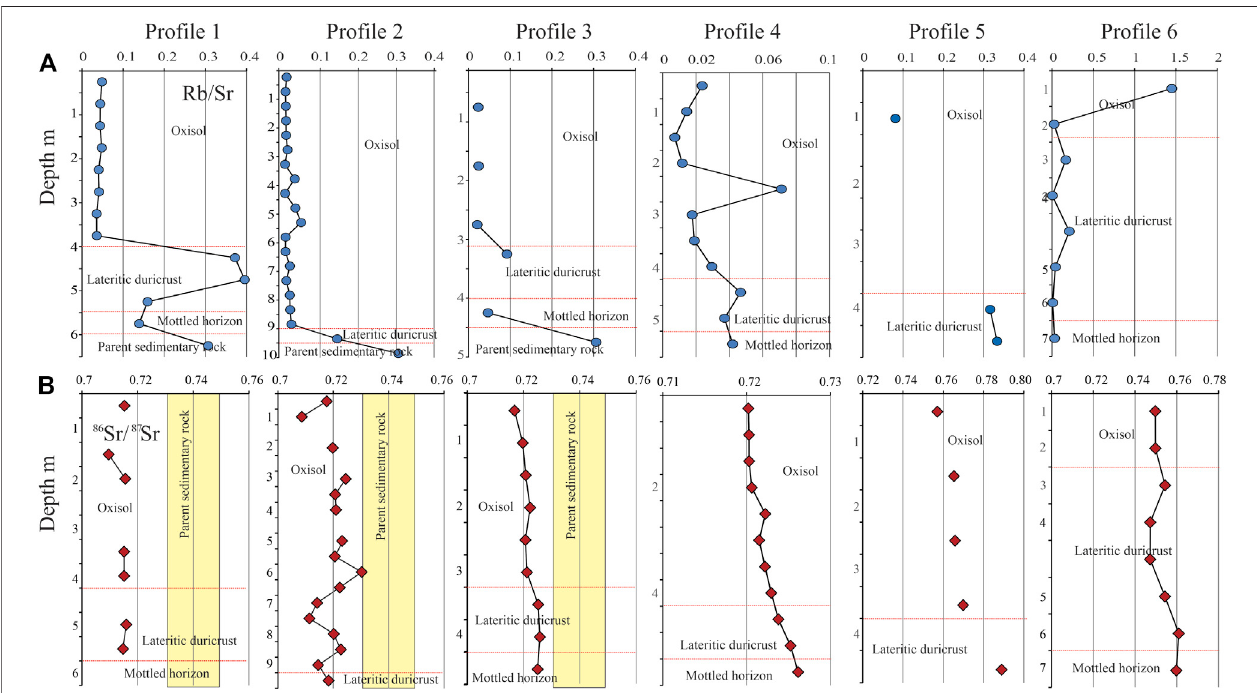
FIGURE 8 | (A) : Plot of Rb/Sr in blue dots color and (B) : plot of 86 Sr/ 87 Sr ratios in red diamond color. The 86 Sr/ 87 Sr values of the parent rocks of pro fi les 1, 2 and 3 are also shown (yellow rectangle). The Rb/Sr ratios decrease from the parent rock and/or the mottled horizon to the lateritic duricrust. There is a trend to less radiogenic 86 Sr/ 87 Sr ratios toward the top of the pro fi les 3 – 6, whereas in the pro fi les 1 and 2 the 87 Sr/ 86 Sr isotope ratios making the horizons isotopically indistinguishable.